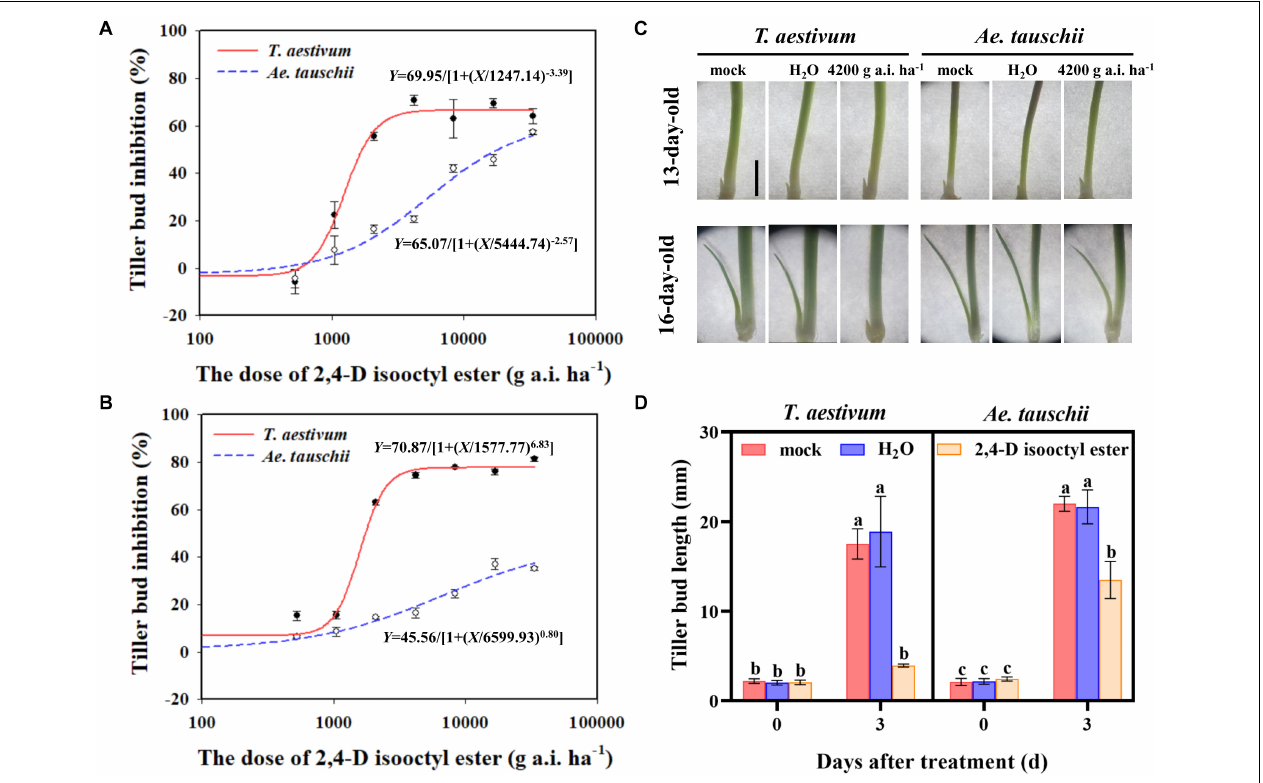
FIGURE 1 | (A,B) Dose response of Triticum aestivum and Aegilops tauschii tiller bud growth to 2,4-D isooctyl ester at 3 (A) and 6 (B) days after treatment (DAT). (C) Phenotypes of T. aestivum and Ae. tauschii tiller buds in the axil of the first leaf at 0 DAT (13-day old) and 3 DAT (16-day-old). The scale bar represents 5 mm. (D) The length of tiller buds located at the axil of the first leaf in T. aestivum and Ae. tauschii at 0 and 3 days after treatment with 4200 g a.i. ha - 1 2,4-D isooctyl ester. Error bars represent the mean ± SD ( n = 3). Different letters represent significant differences (ANOVA, Student-Newman-Keuls test, P <